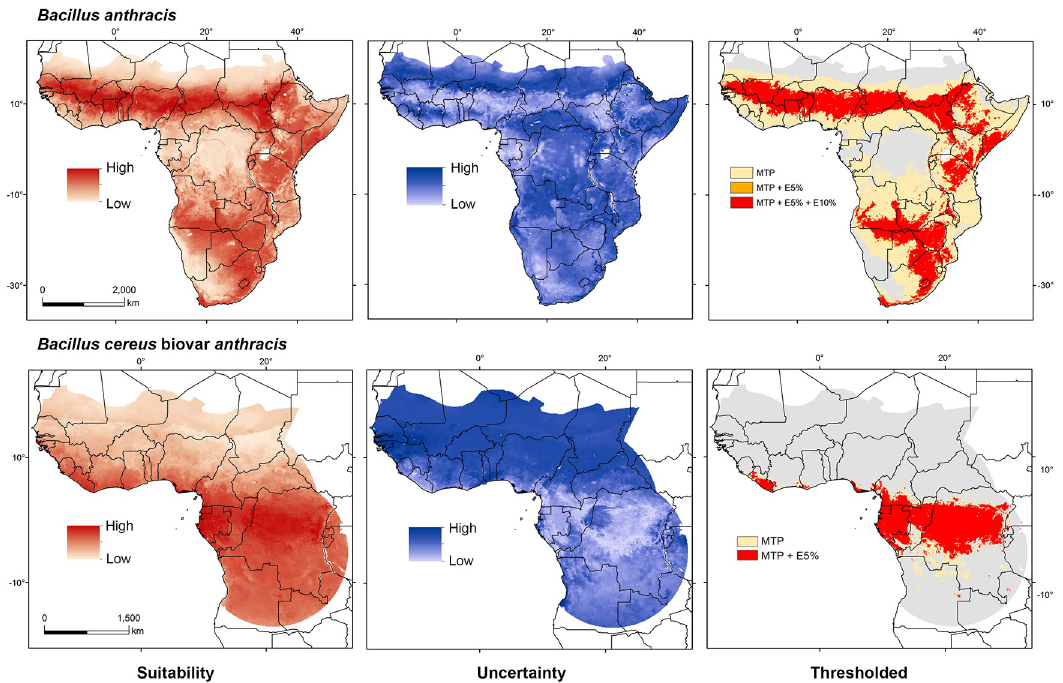
Fig 2. Model outputs for Bacillus anthracis and Bcbva. Models using 30 km thinned occurrence data are depicted for B . anthracis (top) and Bcbva (bottom), as maps of continuous suitability (left), uncertainty (center), and binary maps using different thresholds (right). For B . anthracis (top), binary maps were built using thresholds based on minimum training presence (MTP) in yellow, E = 5% in orange, and E = 10% in red. For Bcbva (bottom), binary maps were built using MTP (yellow) and E = 5% (red) thresholds. Maps were developed using shape files of Africa from the public domain repository of Natural Earth (http://www.naturalearthdata. com/) and built with ArcGIS 10.3 (ESRI Redlands, CA,